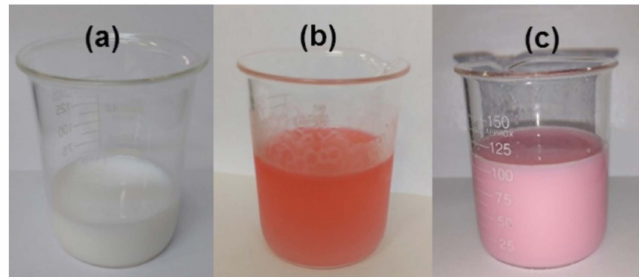
Figure 3. ( a ) MMA emulsion without the addition of RAFT agent; ( b ) MMA emulsion + RAFT agent before sonication; ( c ) MMA emulsion + RAFT agent after sonication.